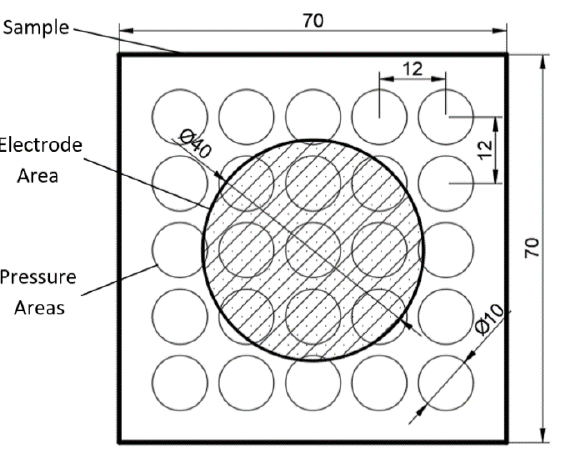
Figure 7. Sample measurement points distribution, and charging electrode over sample (dimen- sions in mm). in